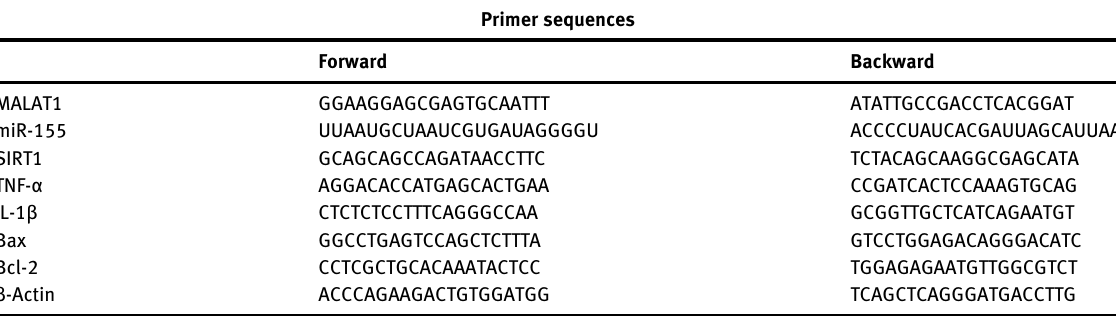
Table  : Primers sequences in the real-time quantitative polymerase chain